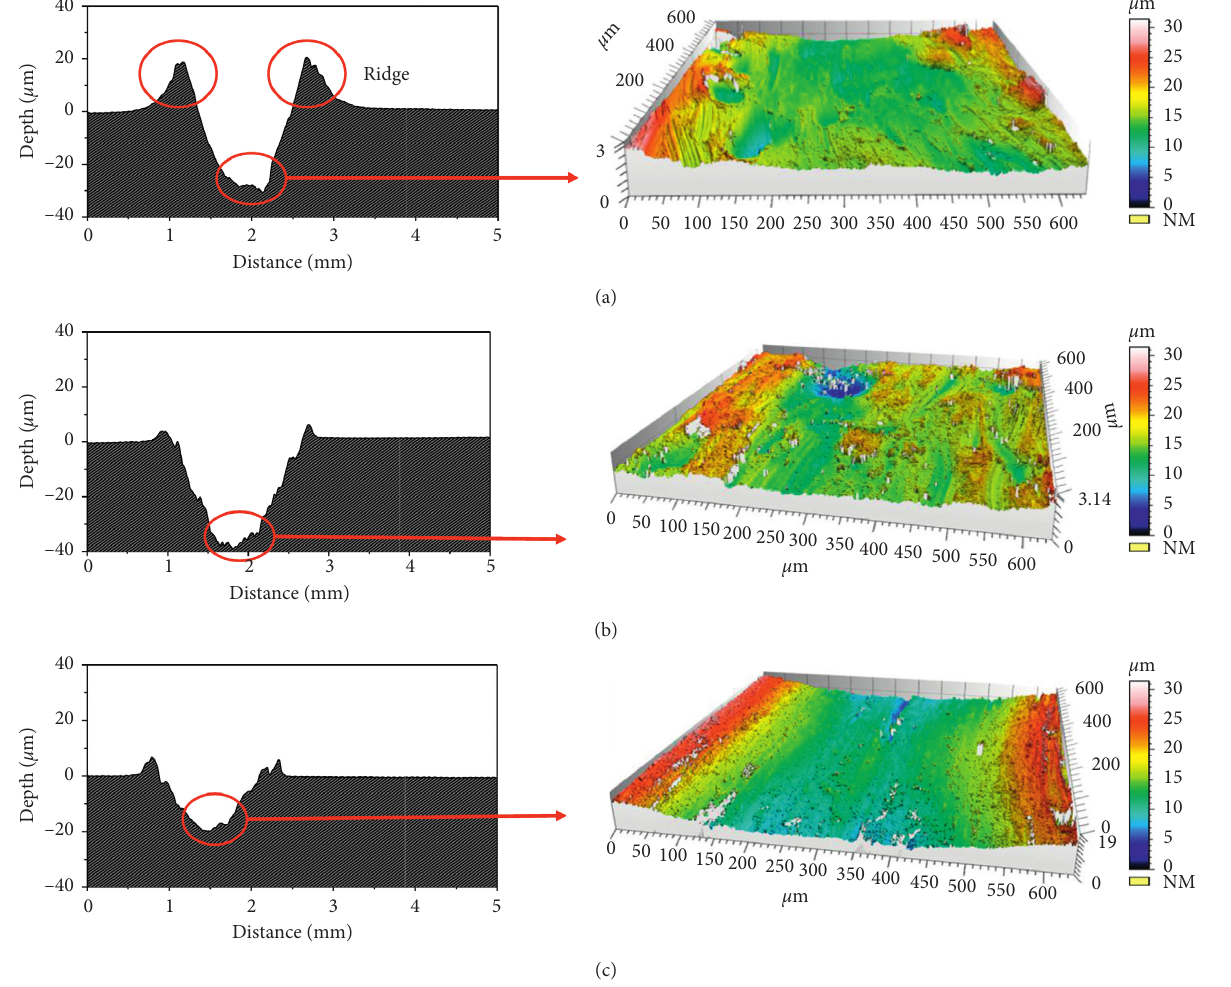
Figure 10: Three-dimensional morphologies of the wear surfaces of Inconel 625 by Si 500 ° C and under a load of 15N (a) 525mm/s, (b) 350mm/s, and (c) 175mm/s.